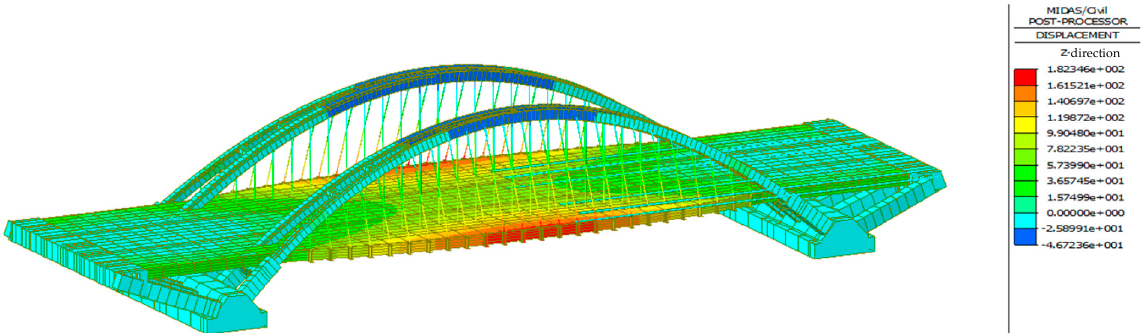
Figure 24. Deformation of the box girder after installation of arch ribs (unit: mm).